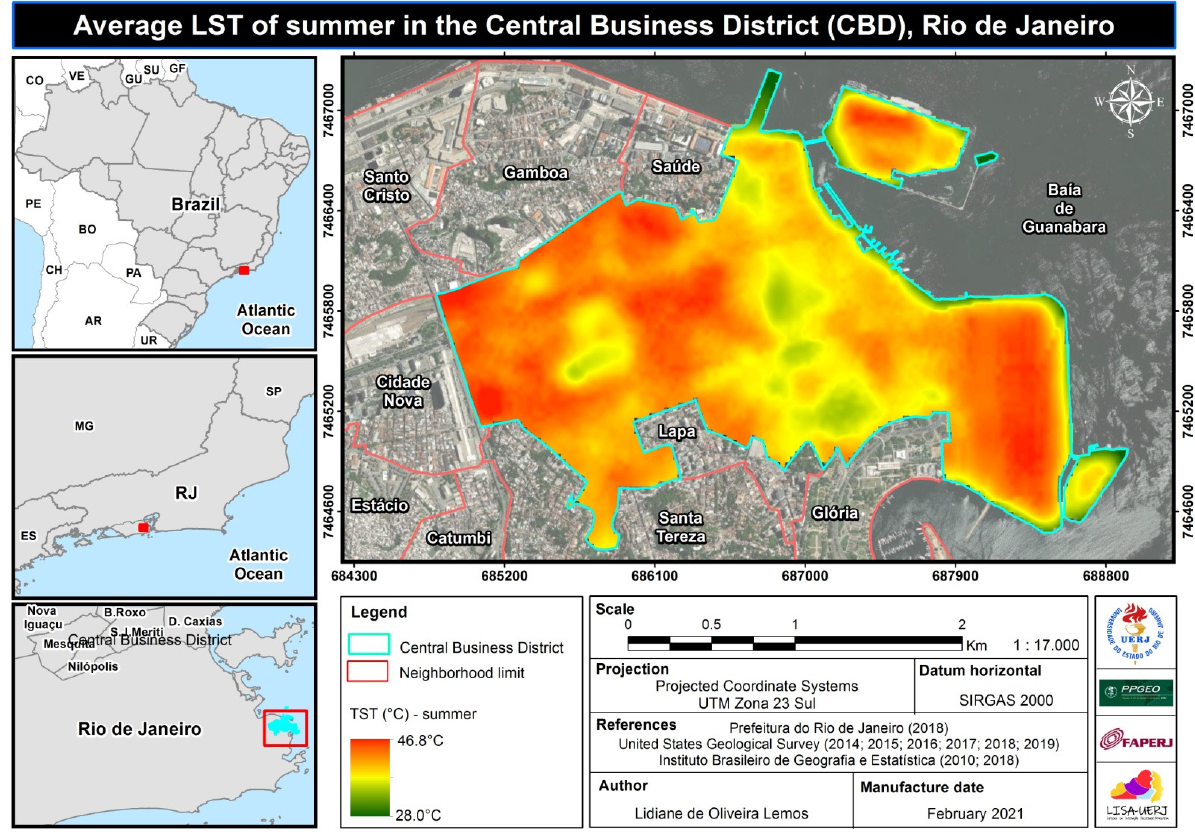
Figure 3. Average land surface temperature (LST) of summer in the central business district (CDB), Rio de Janeiro.